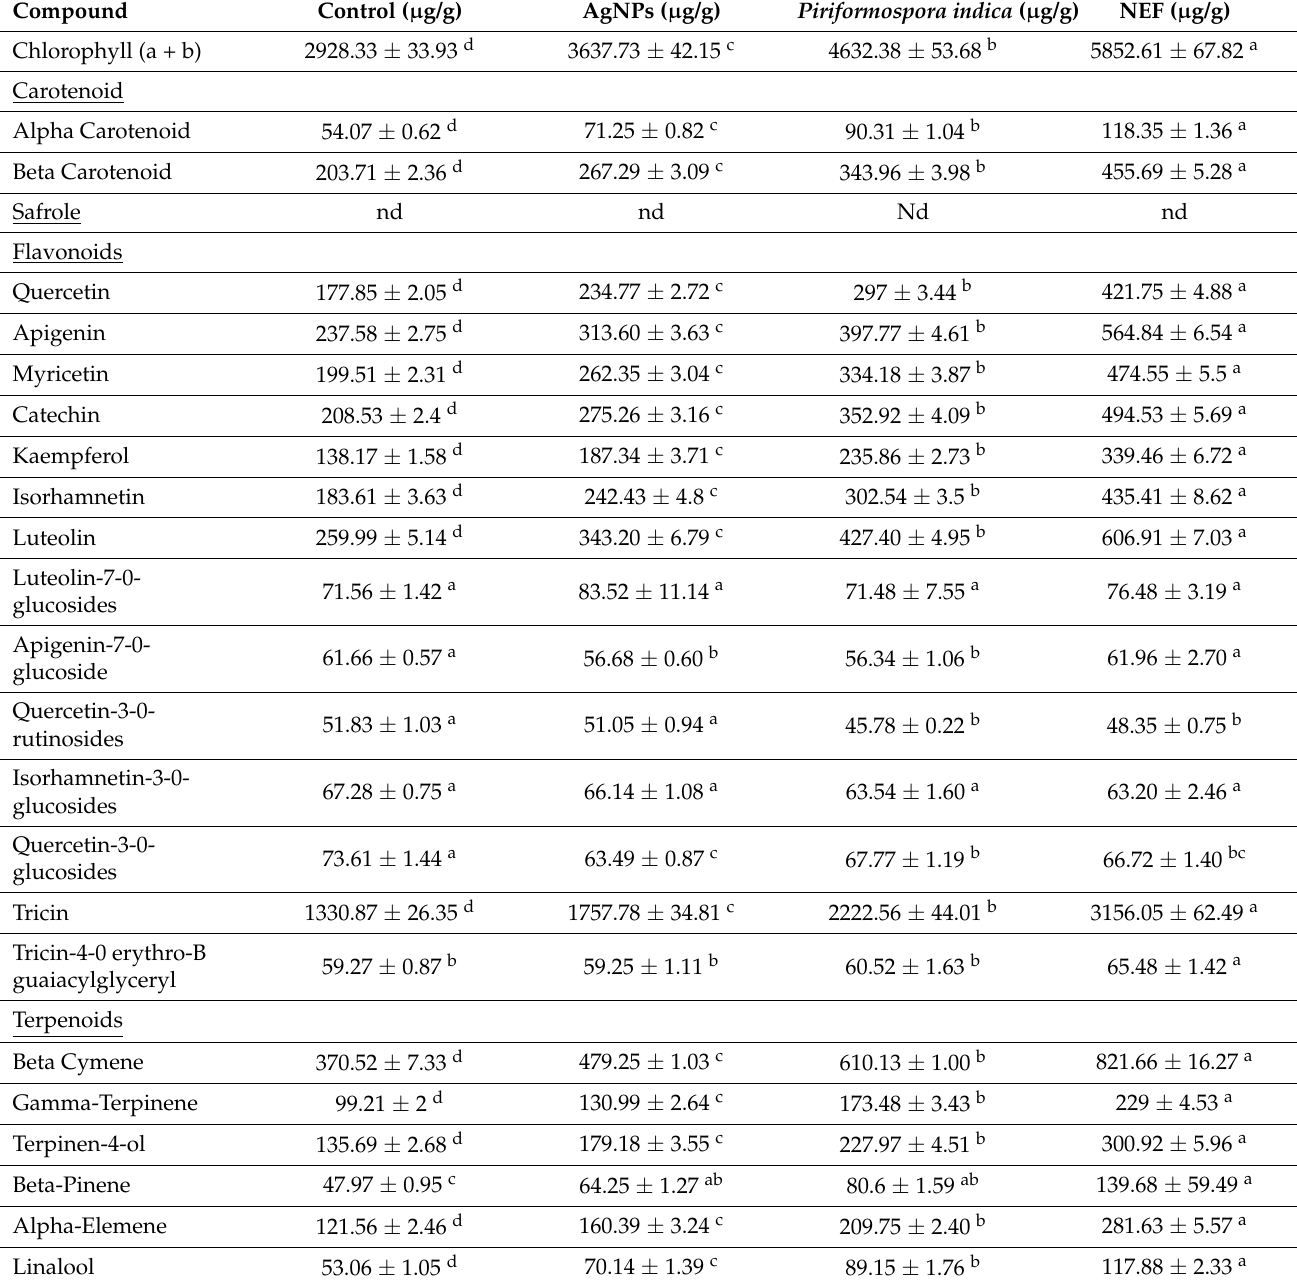
Effect of silver nanoparticle and Piriformospora indica ( Serendipita indica ) and their co-application on secondary metabolite composition of black rice Oryza sativa